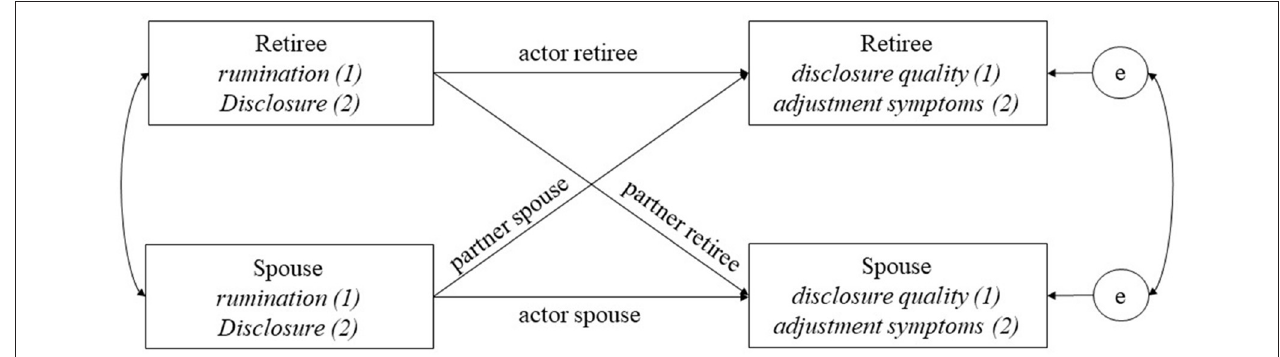
FIGURE 1 | Conceptual model of this study: APIM depicting actor and partner effects that will be analyzed over time within couple. First research question: actor and partner effects of rumination on perceived disclosure quality and second research questions: actor and partner effects of retirement-related disclosure on daily adjustment disorder symptoms.